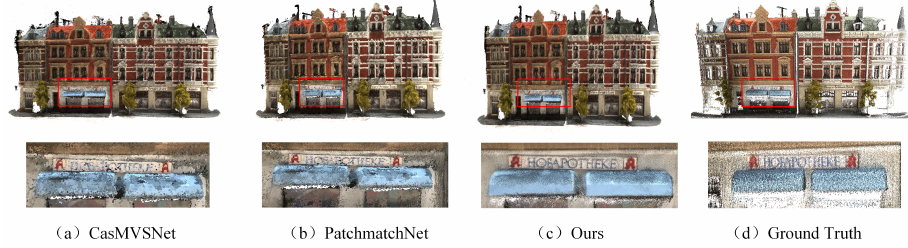
Figure 3. Qualitative comparion of scan15 of DTU [9]: bottom, zoom in; our method preserves the integrity of the blue roof better than PatchMatchNet [15], with smoother results and finer detail in the logo